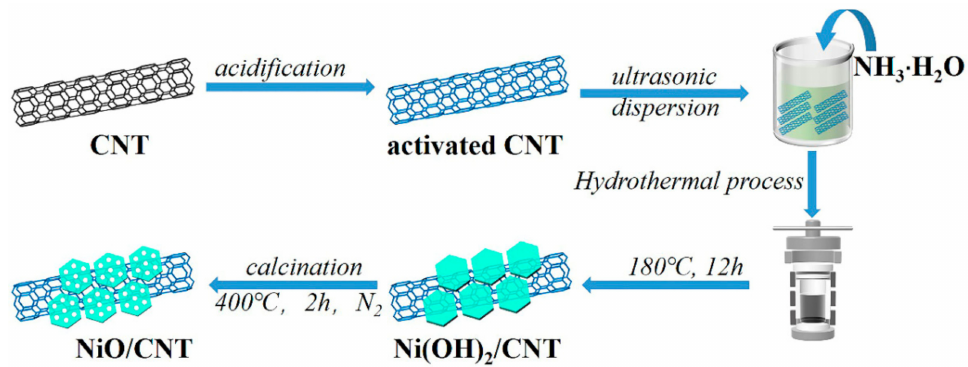
Figure 1. Schematic illustration of the fabrication of NiO/CNT composites.